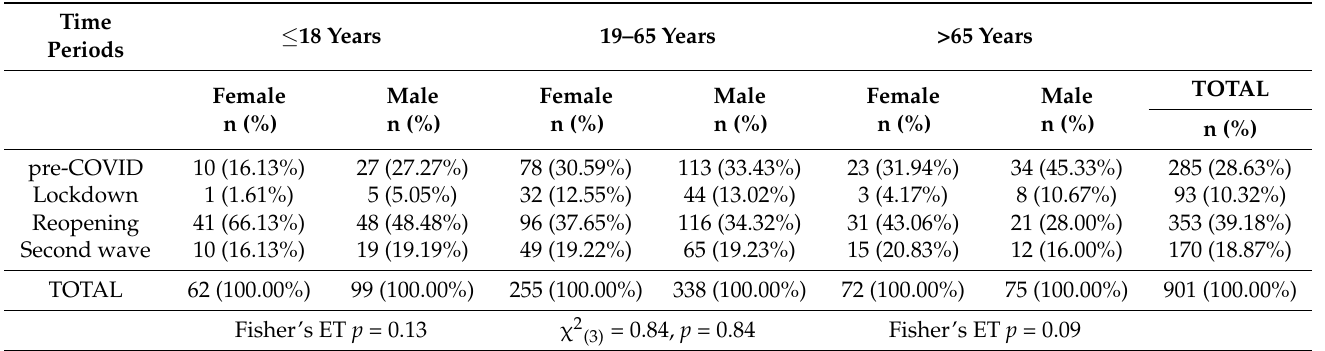
Table 1. Age and sex of patients attending the Urgent Dental Care Service (UDCS) of San Paolo Hospital in Milan during the four time periods considered.